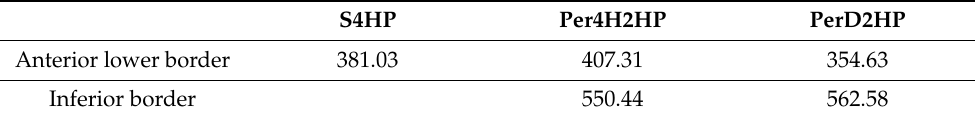
Table 3. The MaxVMS of plates in three fixation groups on mandibular symphysis fracture (unit: